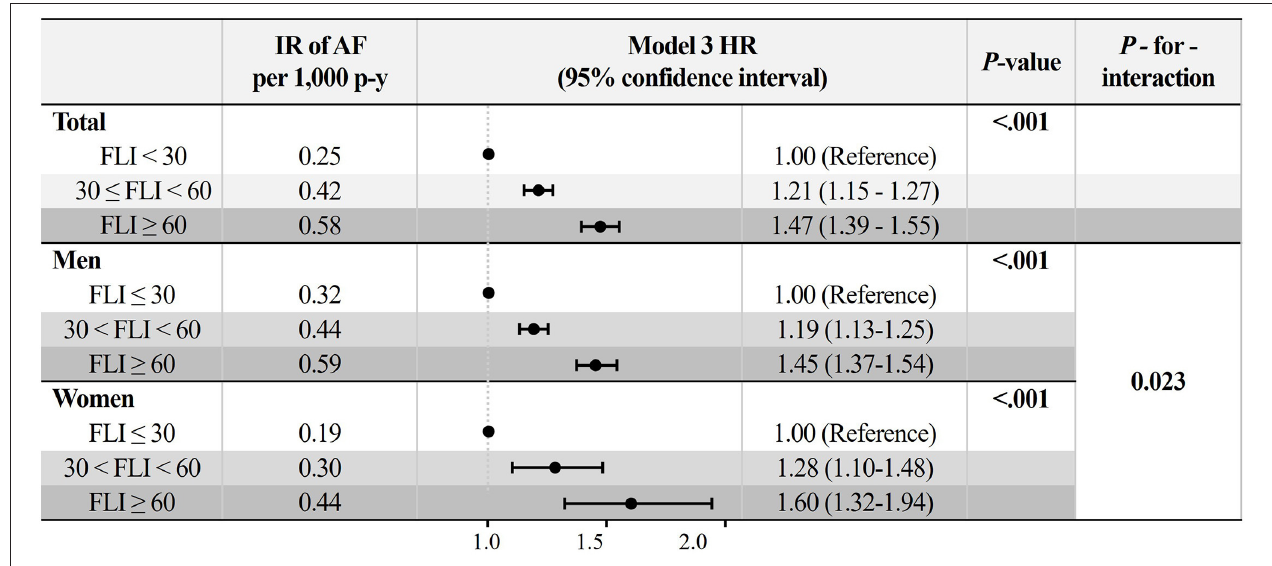
FIGURE 2 | Incidence rate and adjusted hazard ratios (95% confidence interval) of AF in different fatty liver index group. Model 3: adjustment of age, sex, hypertension, diabetes mellitus, dyslipidemia, heart failure, prior ischemic stroke, prior myocardial infarction, chronic obstructive pulmonary disease, chronic kidney disease, sleep apnea, hyperthyroidism, smoking, alcohol consumption, and low income. AF, atrial fibrillation; IR, incidence rate.